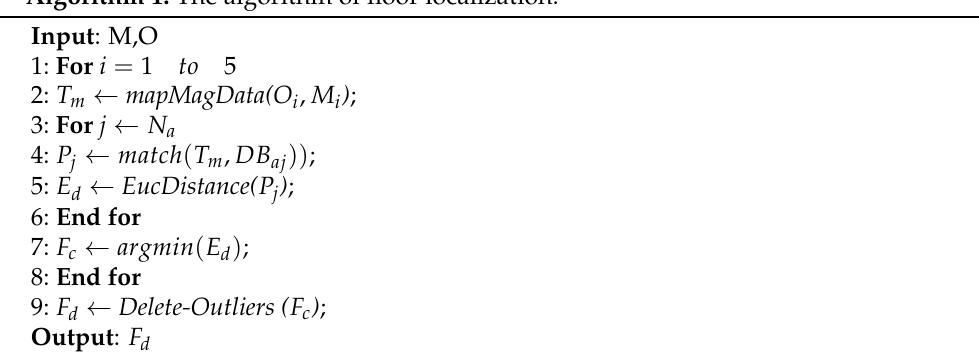
Algorithm 1: The algorithm of floor